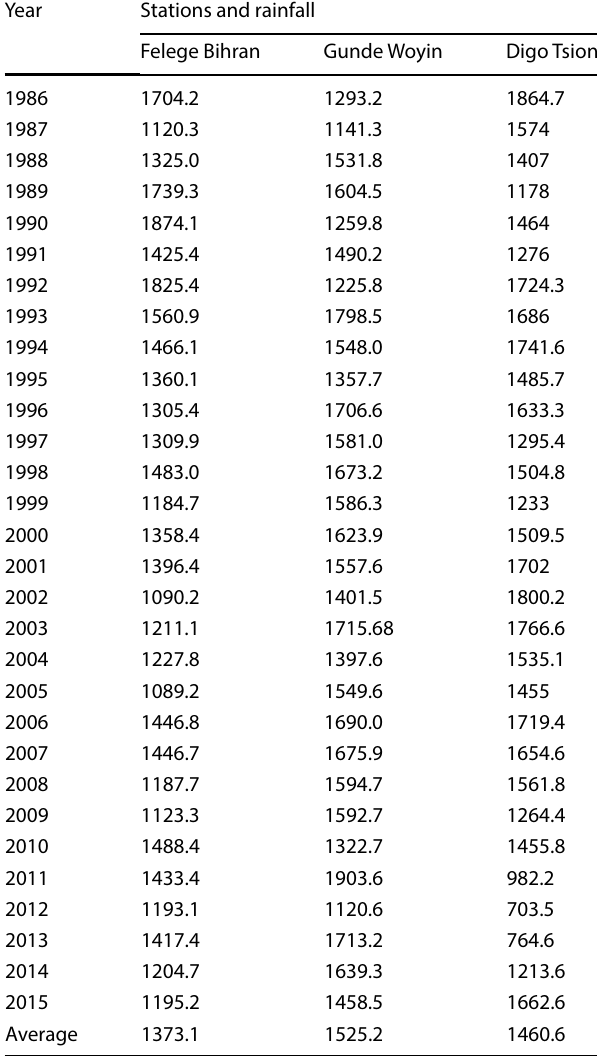
Table 3 Average annual rainfall of stations (mm) Year Stations and rainfall